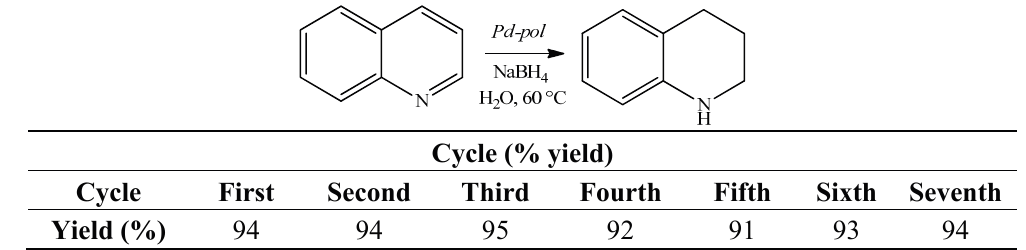
Table 4. Transfer hydrogenation of quinoline to 1,2,3,4-tetrahydroquinoline over seven cycles a .